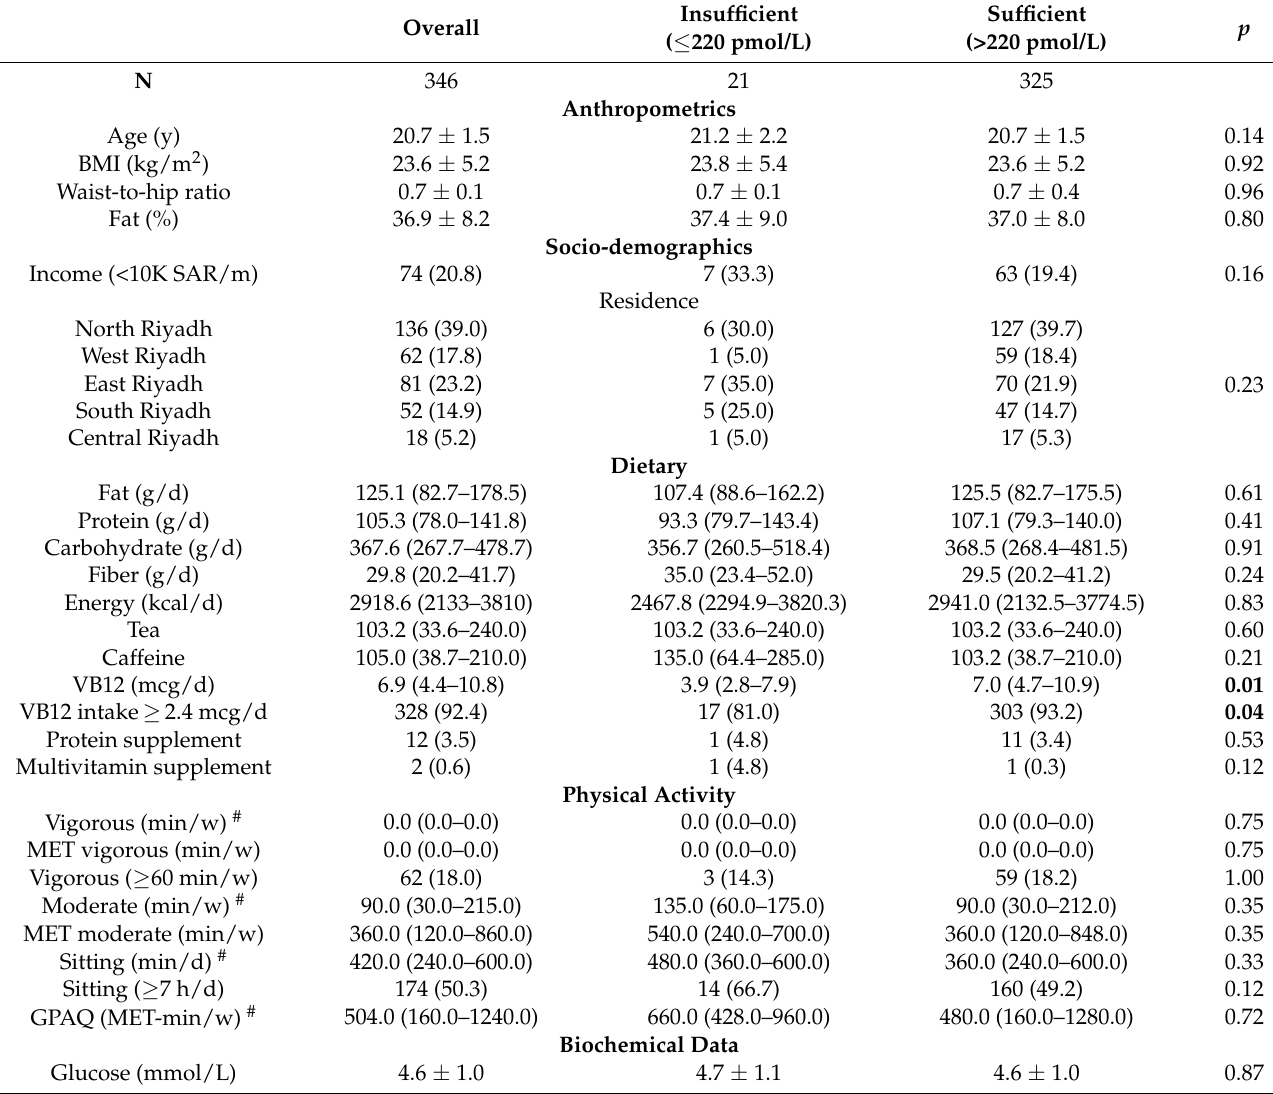
Table 1. Baseline characteristics in relation to vitamin B12